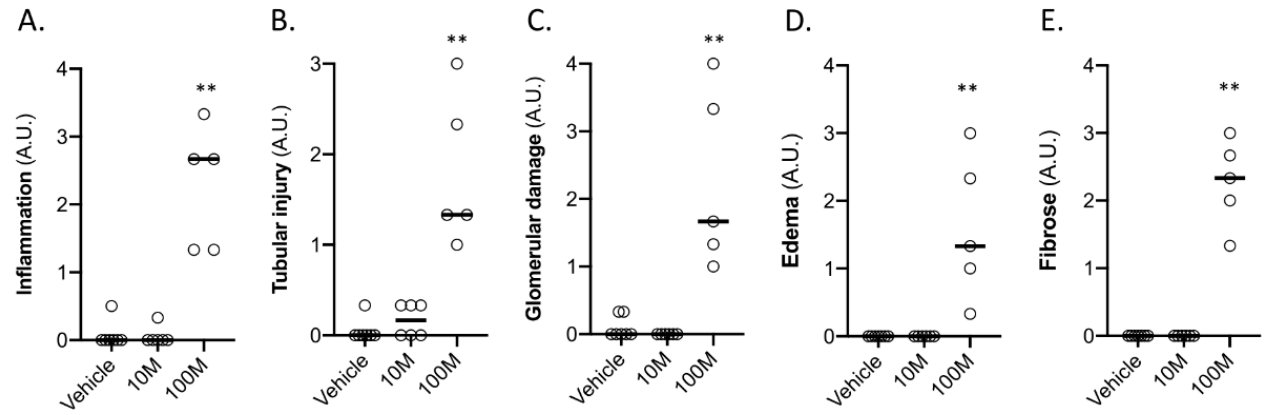
Figure 3. Histological assessment of the treated kidneys two weeks after intra-renal arterial MSC administration (right kidney). The animals were treated with vehicle (PBS; n = 7), ten million MSCs (10M; n = 6), and one hundred million MSCs (100M; n = 5). Kidneys were scored for inflammation (A), tubular injury (B), glomerular damage (C), oedema (D), and fibrosis (E). Scoring that was used for inflammation, glomerular damage, oedema, and fibrosis: 0 (<1% affected), 1 (1–5% affected), 2 (6–25% affected), 3 (25–50% affected), and 4 (50–100% affected). Scoring that was used for tubular injury: 0 (none), 1 (mild), 2 (moderate), and 3 (severe). In total, three regions per kidney were scored and the average values per kidney are presented. A.U., arbitrary unit. Graphs present the individual values with the median. ** p < 0.01 vs. vehicle group.